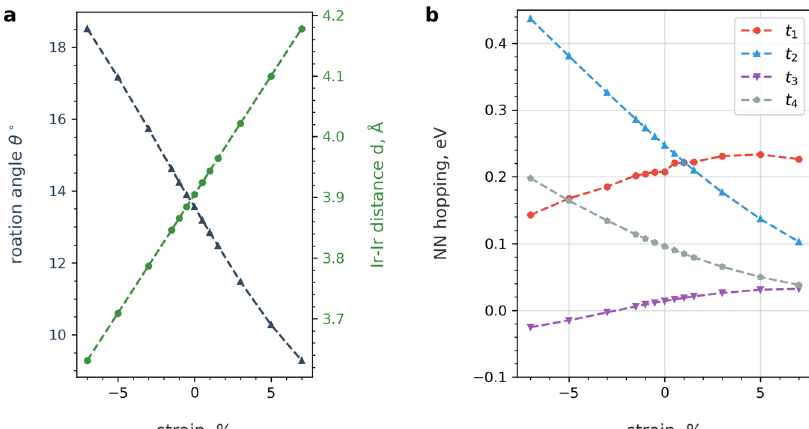
Fig. 2 Dependency of the octahedra rotation angle θ , Ir-Ir distance d, and NN hopping parameters on strain. a The in-plane IrO 6 octahedral rotation angle θ and Ir-Ir distance d as functions of strain, obtained with full structure relaxation in DFT calculations (see Methods). b NN hopping parameters for different values of strain, see Fig. 1 for